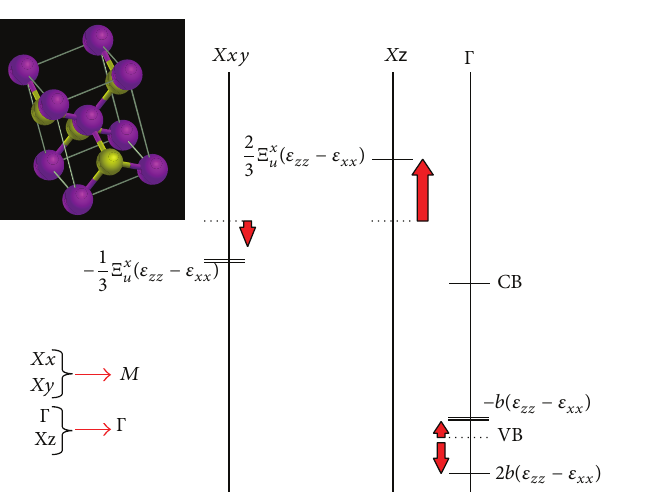
Figure 11: Energy shifts and definition of deformation potentials associated with a pure biaxial strain along the [001] axis at the Γ and 𝑋 points for zinc-blende semiconductors. Splittings of electronic states at the 𝑋 point are also defined. Folding of 𝑋 𝑧 states at the Γ point is associated with the doubling of the primitive unit cell. The tetragonal primitive cell is shown in insert.